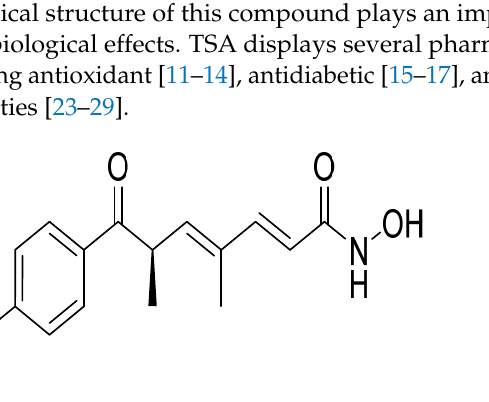
Figure 1. Chemical structure of trichostatin A.